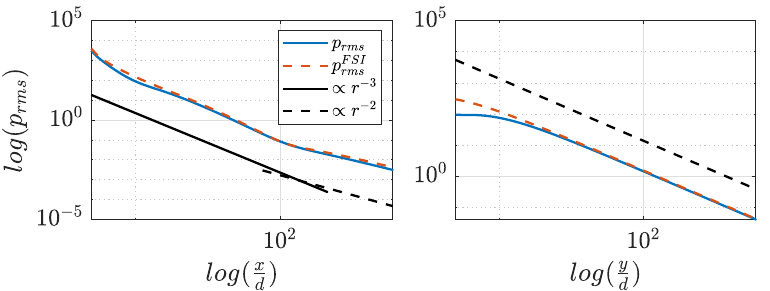
Figure 16. Decay of the acoustic pressure rms along the x -direction ( left ) and the y -direction ( right ): rigid body case, solid blue line; flexible body case, dashed orange line; solid black line, ∝ r − 3 ; dashed black line, ∝ r − 2